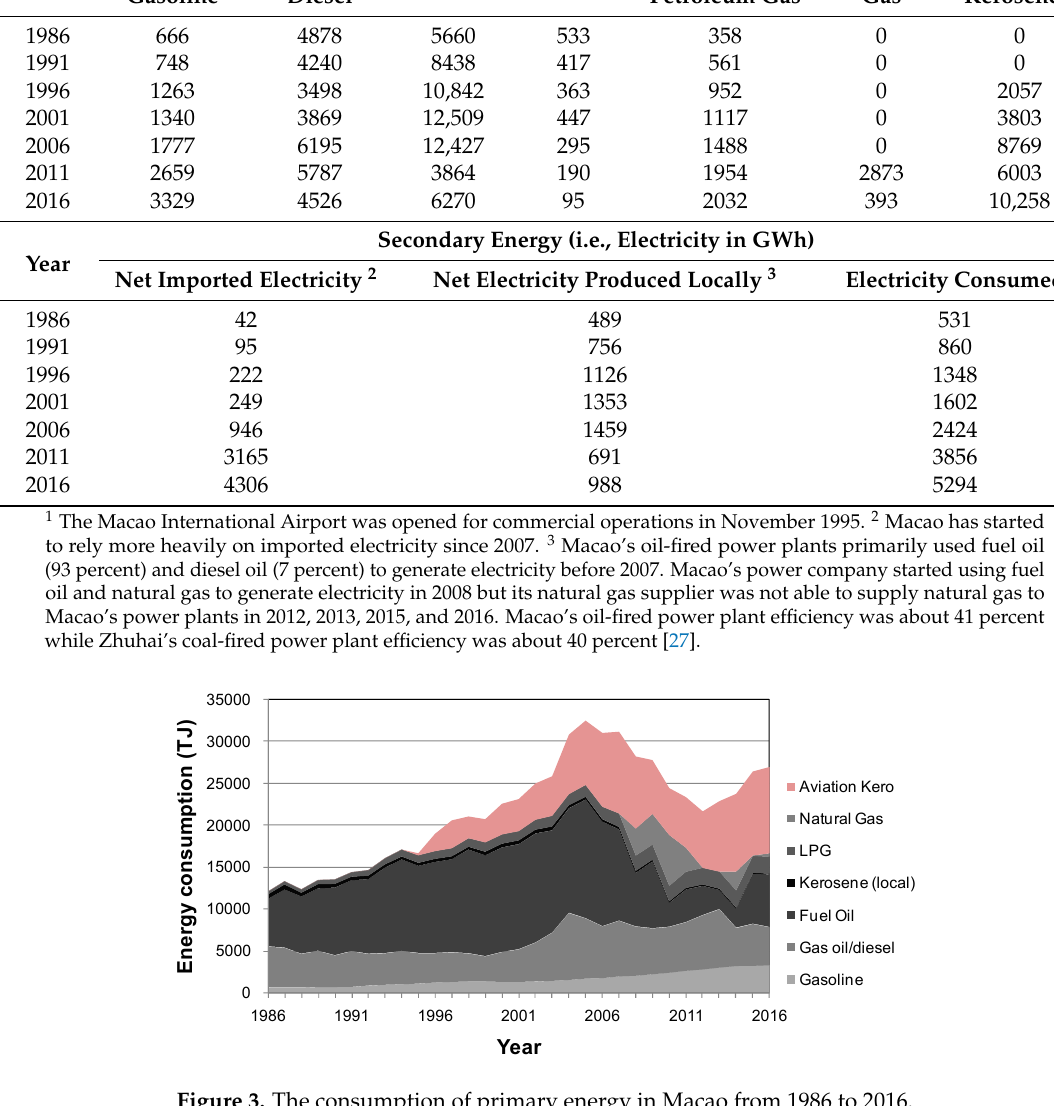
Figure 3. The consumption of primary energy in Macao from 1986 to 2016.